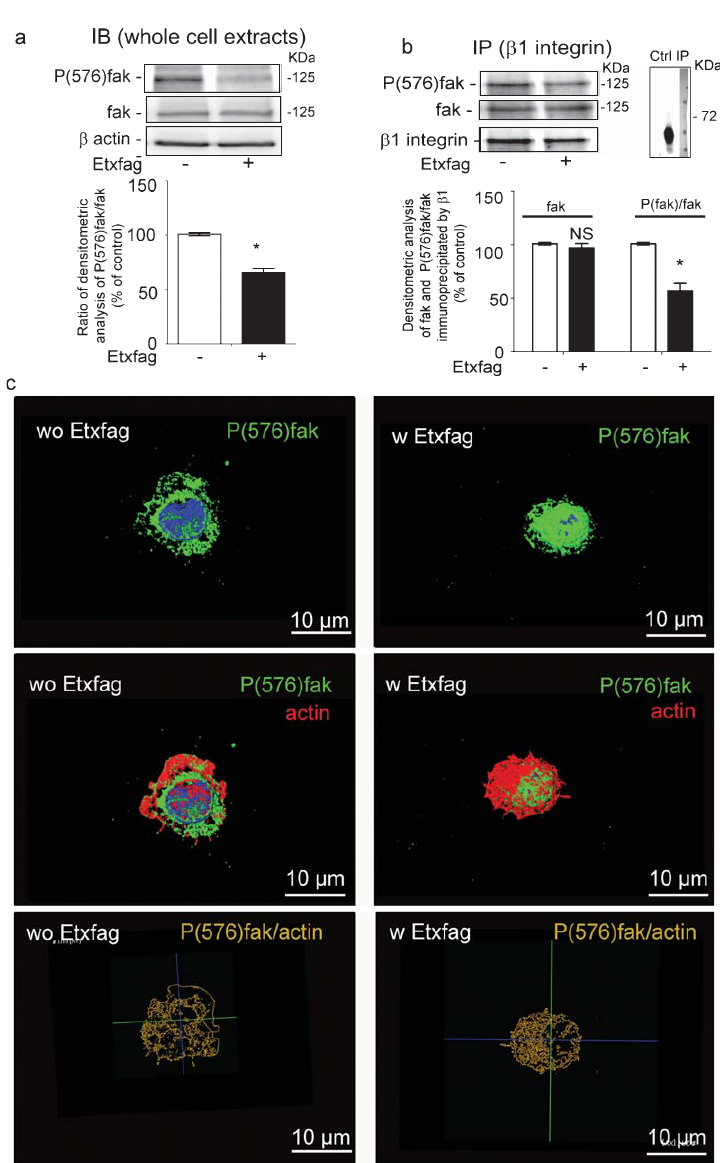
Supplementary Figure 2. Etxfag prevents fak phosphorylation on Tyr 576. a ) Whole cell lysates prepared from L1210 cells treated or not with 1 × 10 − 7 M etxfag during 24h were subjected to immunoblotting with antibodies anti-phosphorylated-Y576 fak and fak. A representative blot of three independent experiments is shown. Graph represents the densitometric analysis of the ratio P(576)fak/fak in control ( (cid:1) ) and treated ( (cid:2) ) cells.* P <0.05. b ) Cell lysates prepared from L1210 cells treated or not with 1 × 10 − 7 M etxfag during 24h were immunoprecipitated with anti- (cid:1) 1antibody and immunoblotted with antibodies anti-phosphorylated-Y576-fak and fak. Non specific IgGs were used as negative controls of immunoprecipitation(windows).Arepresentativeblotofthreeindependentexperimentswasshown.Graphrepresentsthedensitometricanalysis of the ratio P(576)fak/fak in control ( (cid:1) ) and treated ( (cid:2) ) cells.* P <0.05. c ) L1210 cells treated or not with 1 × 10 − 7 M etxfag for 24h were seeded to FN/V for 2h. Cells were fixed with paraformaldehyde 4% and permeabilized with 0.1% Triton X-100. Blue color represents nuclear staining with DAPI. Cells were labelled with antibodies anti-phosphorylated-Y576-fak and then with a secondary antibody linked to Alexafluor 488 (green). Cells were also incubated with Alexafluor 568-conjugated phalloidin (red) to visualize F-actin distribution. Surfacic reconstructions were realized from L1210 cells treated with (right row) or without etxfag (left row). Upper panels represent P(576)fak labelling, middle panels represent P(576)fak+F-actin labelling and bottom panels represent colocalization between P(576)fak and F-actin (gold). A representative image of three independent experiments is